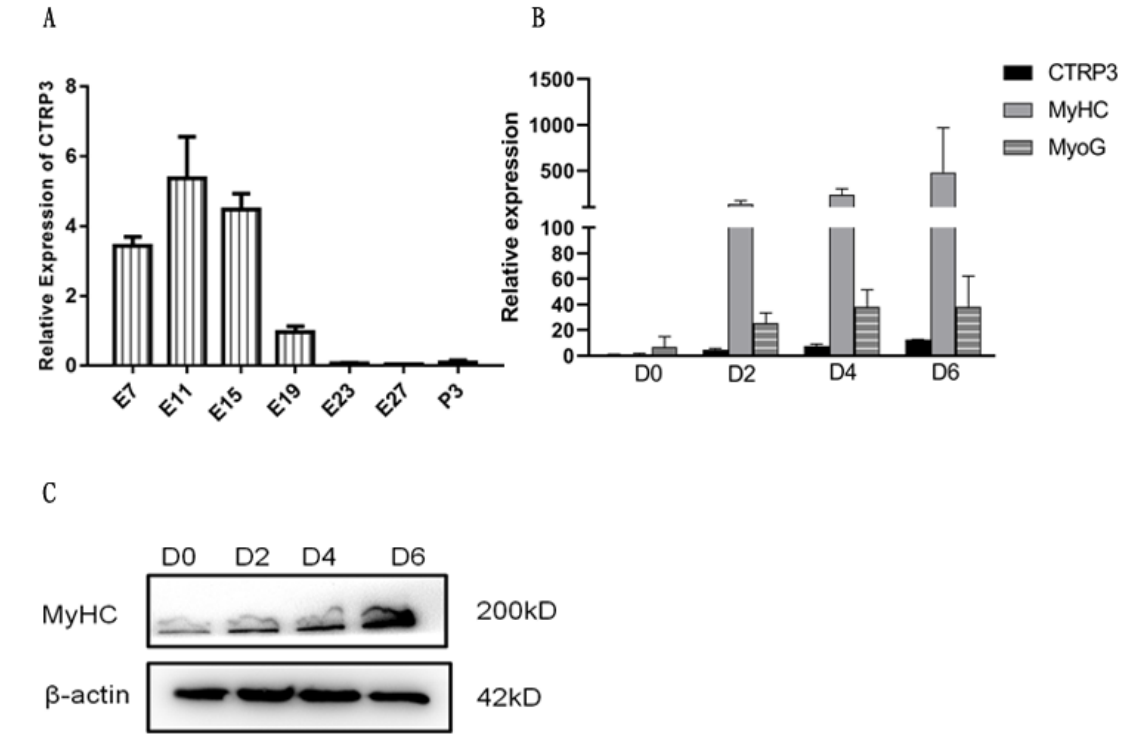
Figure 3. Expression profile of the goose CTRP3 in LM and the marker genes during myogenic differentiation. (A) The CTRP3 mRNA expression level was measured by qPCR during leg muscle development of goose. (B) The mRNA level of MyHC , MyoG , and CTRP3 in 0, 2, 4, and 6 days of cell differentiation. The fold change was relative to day 0 of DM expression. GAPDH was used as the reference gene for Q-PCR. (C) The protein level of MyHC in 0, 2, 4, and 6 days of cell differentiation. β-actin as controls for western blot. Results are expressed as mean±standard error of the mean (n = 3). CTRP3 , C1q and tumor necrosis factor-related protein 3; LM, leg muscle; qPCR, quantitative polymerase chain reaction; MyHC , myosin heavy chains; MyoG , myogenin; GAPDH , glyceraldehyde-3-phosphate dehydrogenase; DM, differentiation medium; qPCR, quantitative pol - ymerase chain